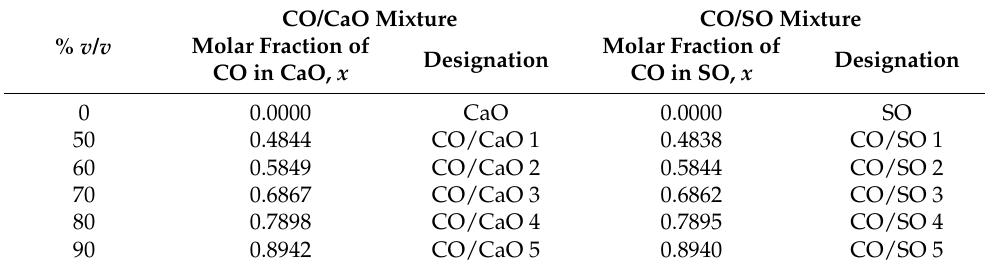
Table 4. Volume and molar concentrations of different binary oil